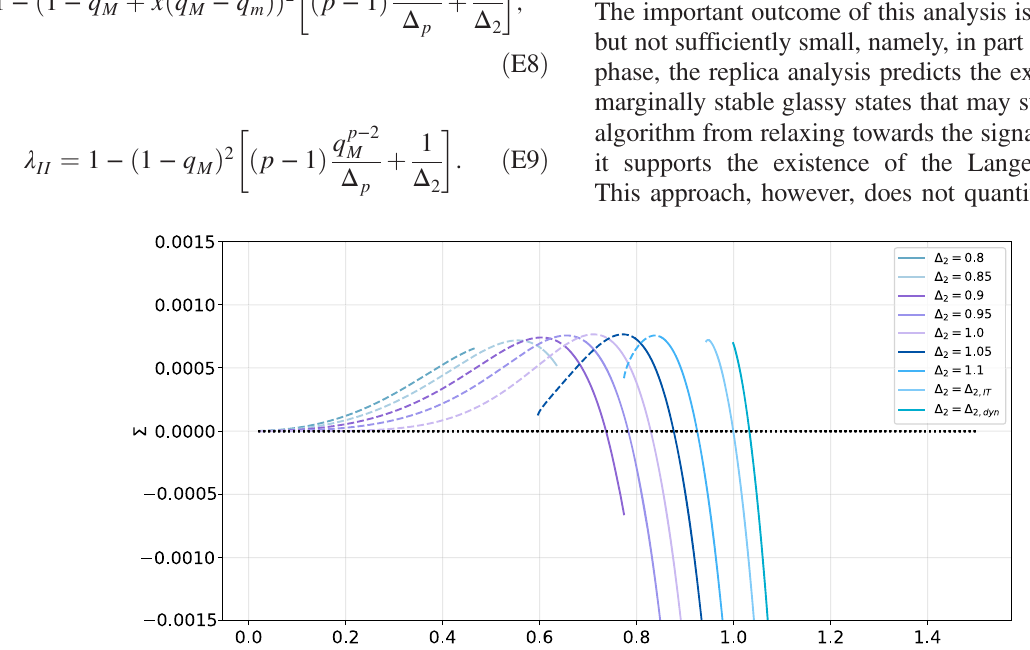
FIG. 20. Complexity as a function of the Parisi parameter x for p ¼ 3 on the line Δ of the complexity, while the dashed line is the unstable